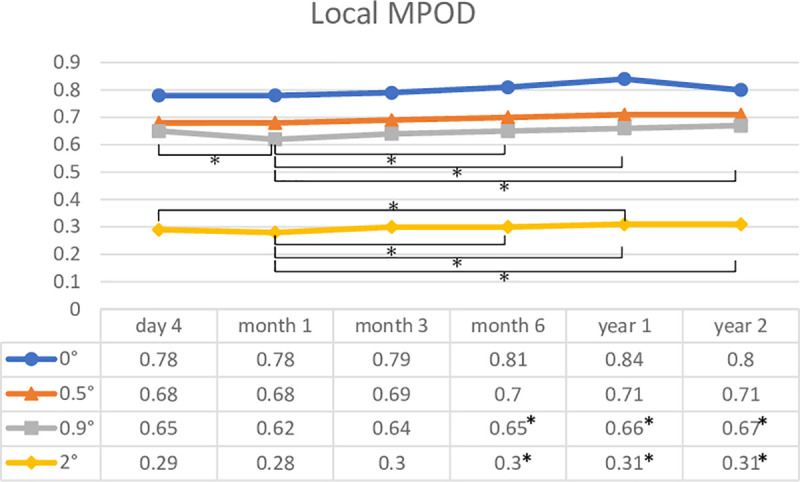
A change in the mean local macular pigment optical density (MPOD) levels in the eyes that had all measurement data during a postoperative follow-up period of 2 years (35 eyes of 22 subjects).Asterisks indicate a significant difference (p < 0.05) in local MPOD levels between two time points.